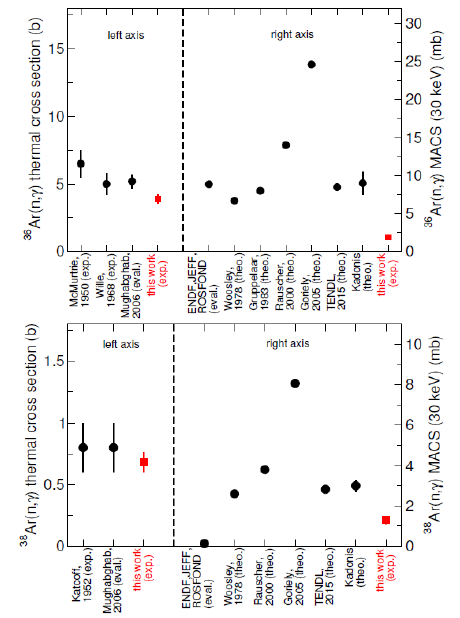
Figure 9. (right panels) Comparison of 36 , 36 Ar neutron capture 30 keV MACS’s measured in this work with theoretical values and evaluations. Interpretation of the observed substantial dis- crepancies are being studied; (left panels) thermal cross sections measured in this work for 36 , 36 Ar are compared to previous ex- perimental results and show good